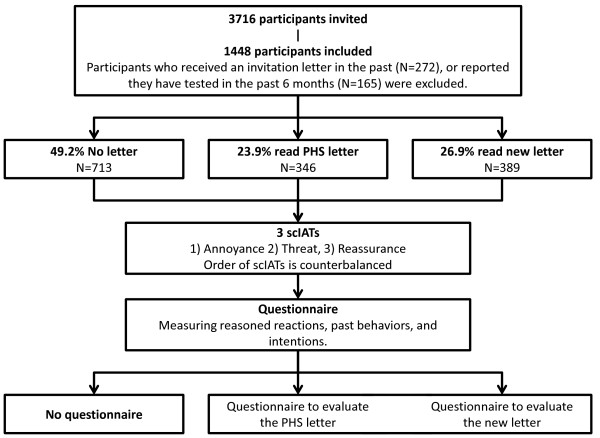
Flowchart illustrating the procedure of the study and the number of participants.